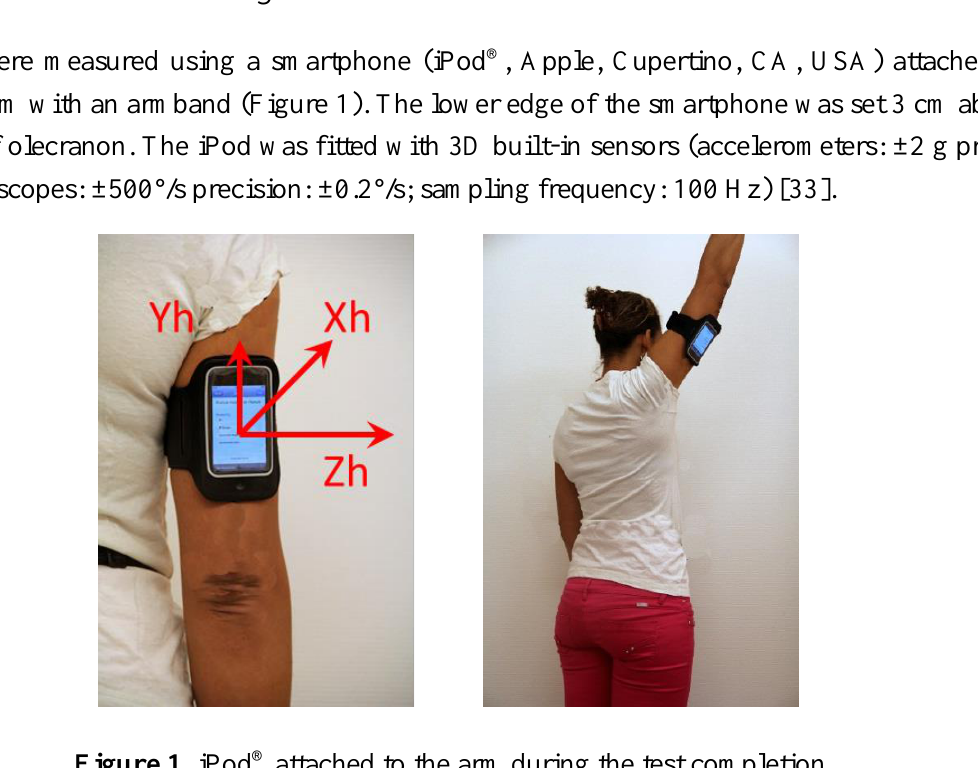
Figure 1. iPod ® attached to the arm during the test